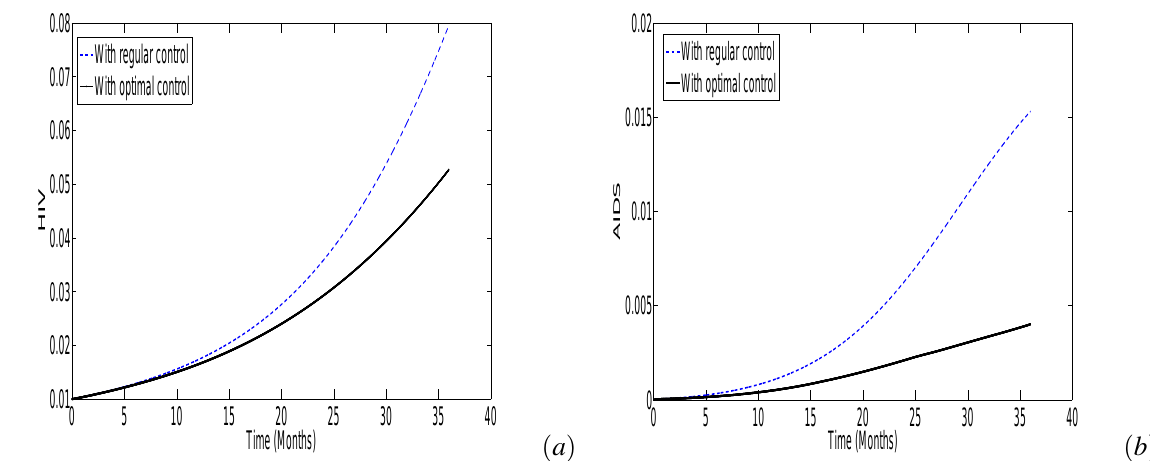
Fig. 2 Graphs of the numerical simulation of the optimality system, showing the propagation of ( a ) HIV cases only and ( b ) AIDS cases over a period of 36